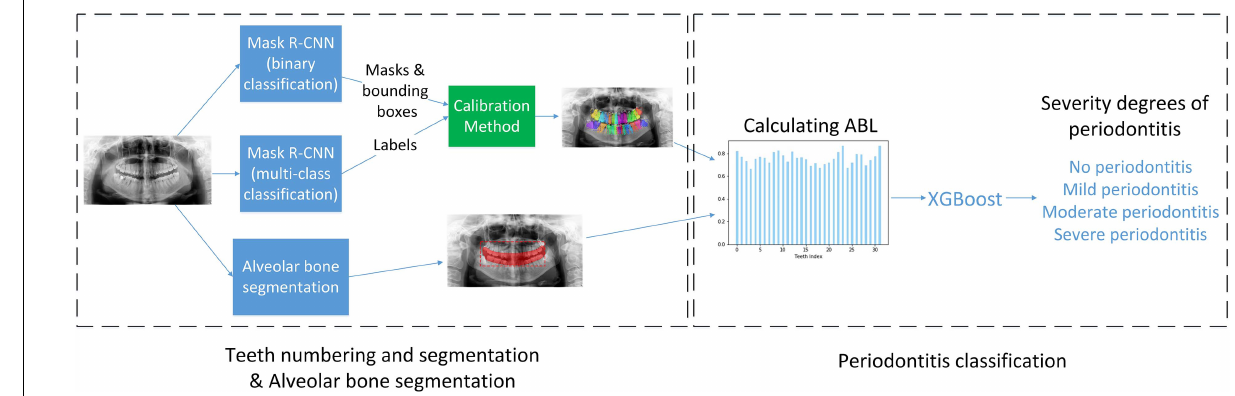
FIGURE 2 | The workflow of Deetal-Perio.